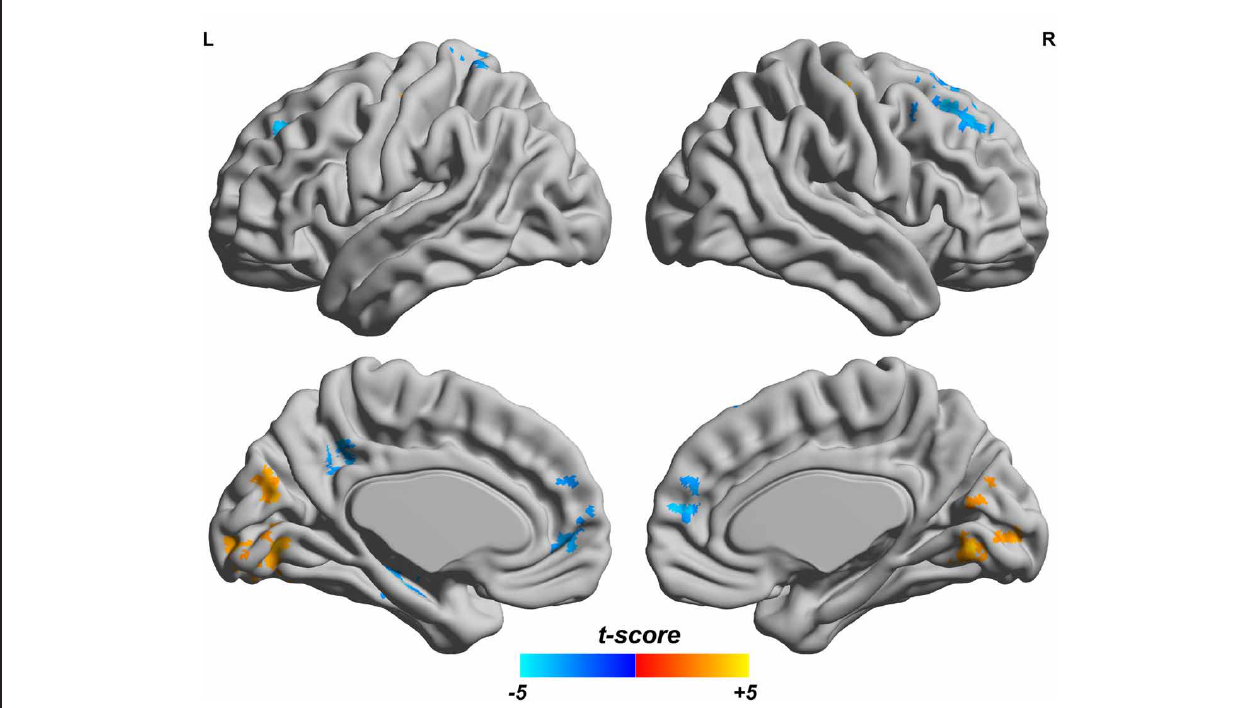
FIGURE 3 | Comparisons of fALFF between the ADHD patients and healthy controls. T-score bar is shown at the bottom. Warm and cold colors indicate ADHD-related fALFF increase and decrease, respectively. Threshold is set at p < 0 . 05 (AlphaSim correction).